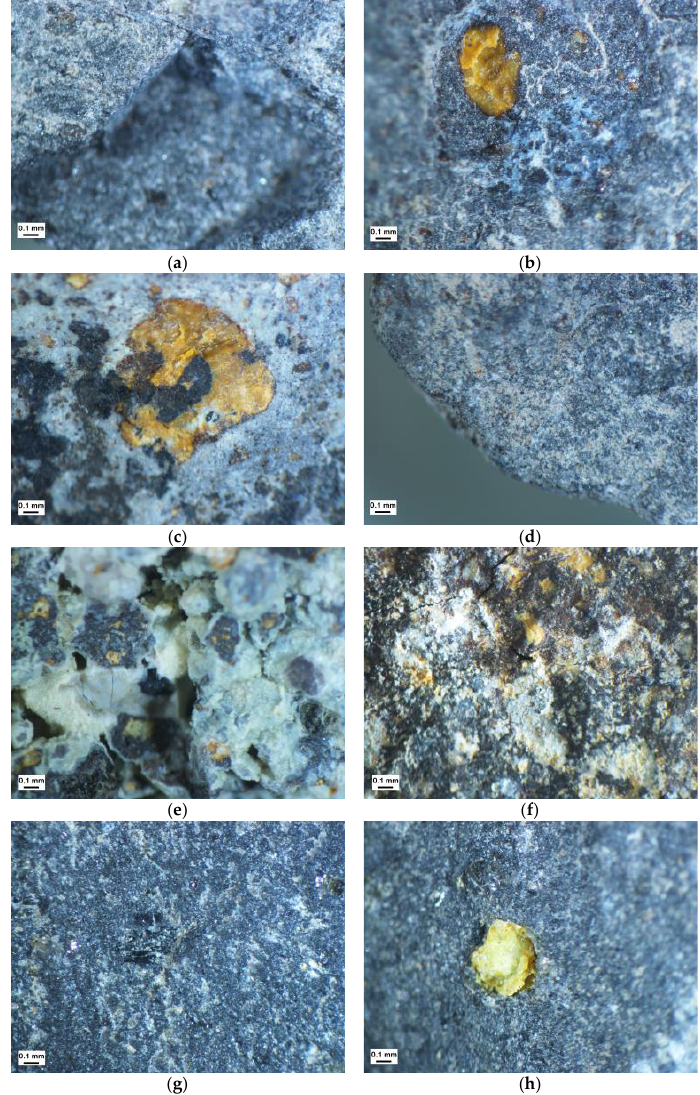
Figure 9. Characteristics of cracks in original samples: ( a ) Basalt aggregate 1, non-flaky grains, +8 mm; ( b ) Basalt aggregate 1, non-flaky grains, +16 mm; ( c ) Basalt aggregate 1, flaky grains, +8 mm; ( d ) Basalt aggregate 1, flaky grains, +16 mm; ( e ) Basalt aggregate 2, non-flaky grains, +8 mm; ( f ) Basalt aggregate 2, non-flaky grains, +16 mm; ( g ) Basalt aggregate 2, flaky grains, +8 mm; ( h ) Basalt aggregate 2, flaky grains, +16 mm.